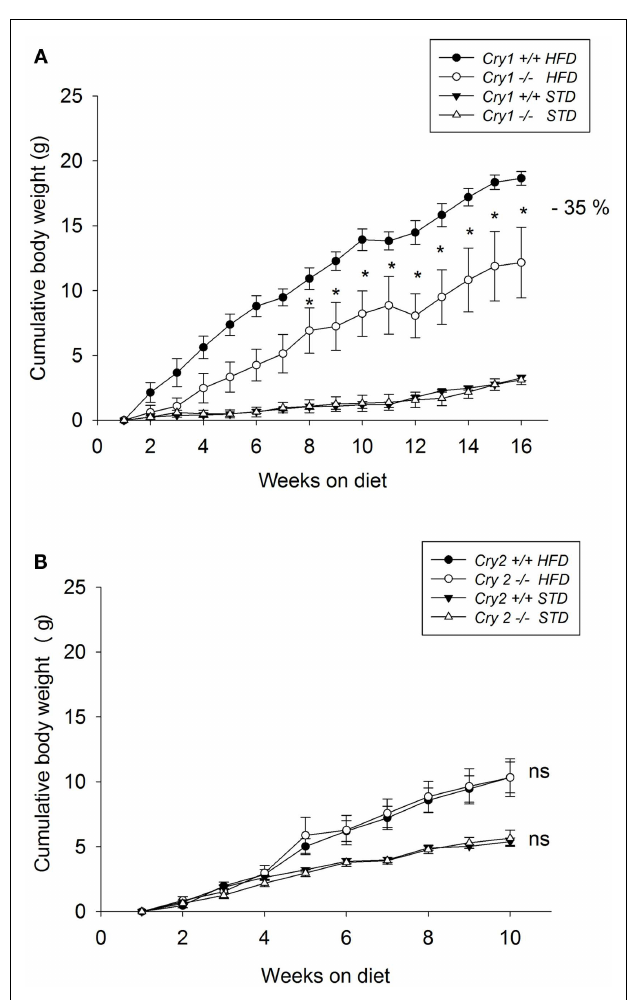
FIGURE 2 | Cumulative weight gain as calculated from mean weights ofWT control, Cry1- , and Cry2 -deficient mice under STD and HFD . (A) Cry1 + / + (filled symbols) and Cry1 − / − (open symbols) mice, (B) : Cry2 + / + (filled symbols) and Cry2 − / − mice (open symbols), determined once a week, on STD (triangles) and HFD (circles) regimens. Cry1 group: n = 5 ( Cry1 + / + -STD) and 5 ( Cry1 − / − -STD) and n = 4 ( Cry1 + / + -HFD) and 5 ( Cry1 − / − -HFD); Cry2 group: n = 6 ( Cry2 + / + -STD) and n = 7 ( Cry2 − / − -STD), and n = 8 ( Cry2 + / + -HFD) and n = 6 ( Cry2 − / − -STD). * P < 0.05, ns P > 0.05 indicated for genotype comparison, two-way ANOVA for body weight with repeated measures on factor week.Values shown are mean ± SEM. Body weight Body weight was not significantly different between mutant mice and WT animals when the feeding trials started ( Cry2 + / + = 23.5 ± 0.6 g; Cry2 − / − = 23.9 ± 0.8 g). When main- tained on a STD for 10 weeks, body weight changes did not differ significantly between Cry2 + / + and Cry2 − / − mice ( Figure 1B ). After 10 weeks on the HFD, Cry2 − / − mice showed similar body weight changes (34.9 ± 1.1 g) than WT mice (34.4 ± 1.8 g). The total weight gain during the feeding period for Cry2 − / − mice on HFD was 10 g ( + 39%), whereas the WT mice on HFD gained 10.3 g ( + 41%) ( Figure 2B